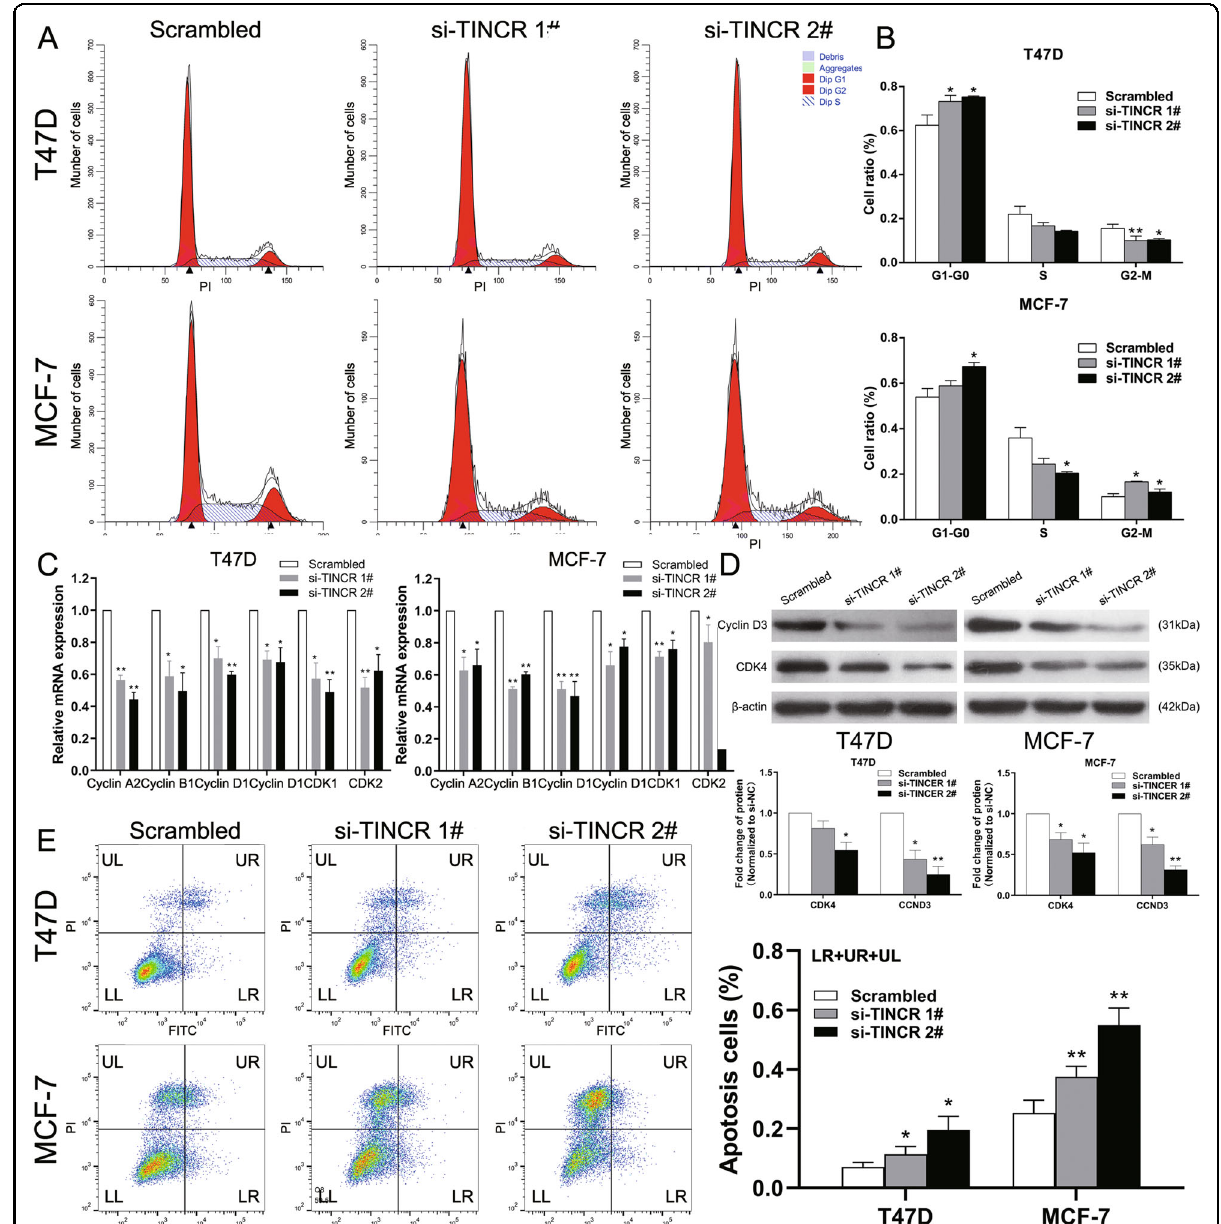
Fig. 3 Effects of TINCR on cell cycle and apoptosis of breast cancer cell in vitro. A , B Cell cycle in breast cancer cells was analyzed by fl ow cytometry. C qRT-PCR analysis of Cyclin A2, Cyclin B1, Cyclin D1, Cyclin D3, CDK1, and CDK2 in breast cancer cells. D Western blot analysis of CyclinD3, CDK4 in T47D and MCF-7 cells. β -actin protein was used as an internal control. E Apoptotic rates of cells were tested by fl ow cytometry. LR: early apoptotic cells, UR: terminal apoptotic cells. UL: necrotic cells and terminal apoptotic cells. Values are shown as the mean±s.d in three independent experiments. The mean values of two groups were compared via paired, two-tailed Student t tests.* P <0.05, ** P